Question: Compose a caption that would accompany this figure in a paper.
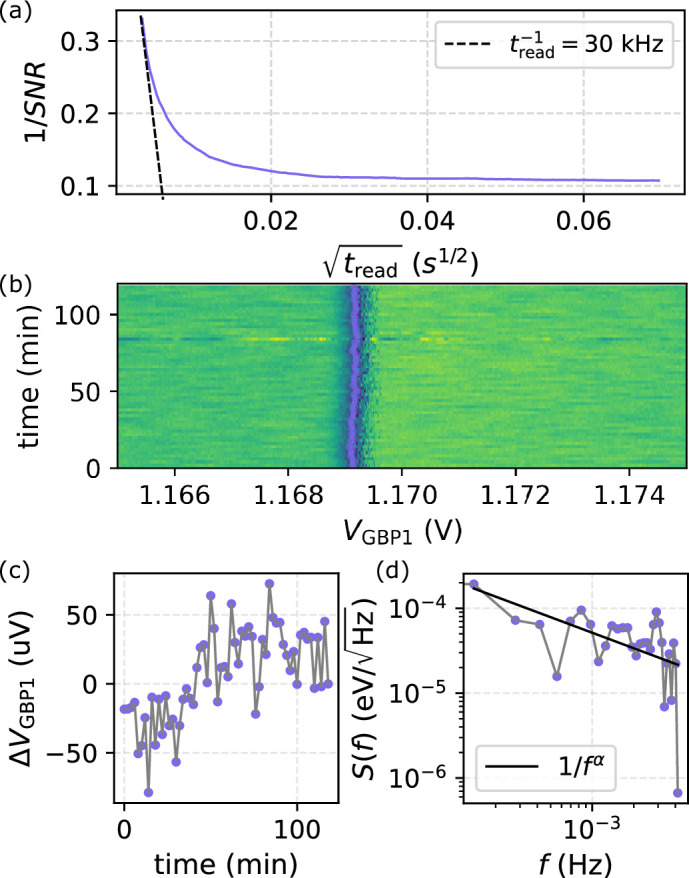
Answer: Noise analysis. ( a ) Fast noise: at fixed signal 1/SNR = σ is suppressed linearly with \documentclass[12pt]{minimal} \usepackage{amsmath} \usepackage{wasysym} \usepackage{amsfonts} \usepackage{amssymb} \usepackage{amsbsy} \usepackage{mathrsfs} \usepackage{upgreek} \setlength{\oddsidemargin}{-69pt} \begin{document}$$1/\sqrt{{t}_{{\rm{read}}}}$$\end{document} 1 / t read up until it plateau for \documentclass[12pt]{minimal} \usepackage{amsmath} \usepackage{wasysym} \usepackage{amsfonts} \usepackage{amssymb} \usepackage{amsbsy} \usepackage{mathrsfs} \usepackage{upgreek} \setlength{\oddsidemargin}{-69pt} \begin{document}$${t}_{{\rm{read}}}^{-1} \sim 30$$\end{document} t read - 1 ~ 30 kHz. This is where non-white noise such as charge noise starts to dominate. ( b ) Stability of the SEB: peak tracking of the SEB point with centre obtained from fit to c o s h −2 . ( c ) Slow noise : noise spectral density calculated from welch method and using gate lever-arm α g = 0.14. Fit to S ( f ) = A / f α with α = 0.6 ± 0.2 and A = 0.8 ± 1 × 10 −6 (95% CI).